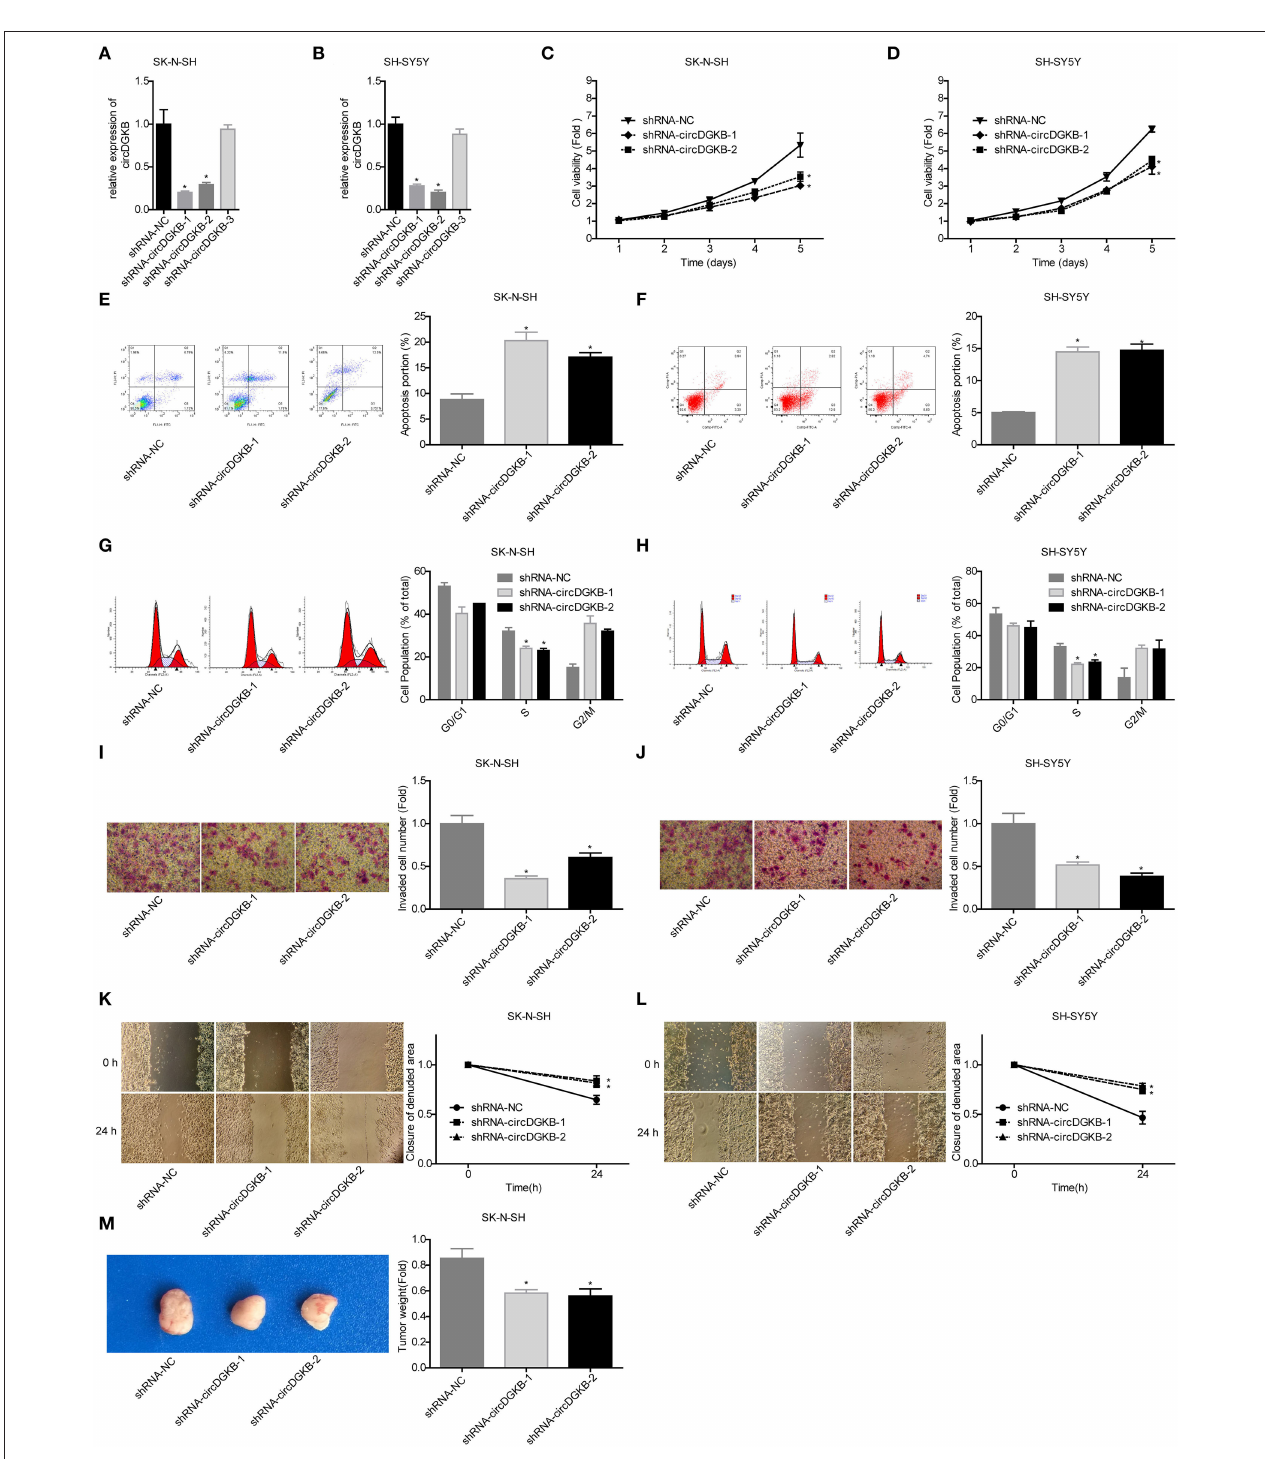
FIGURE 2 | Evaluation of the roles of circDGKB knockdown in NB cell proliferation, apoptosis and cell cycle, migration, invasion, and tumorigenesis. (A,B) QRT-PCR was taken to detect the infected efficiencies of shRNAs-circDGKB in SK-N-SH and SH-SY5Y cell lines. (C,D) CCK-8 assay was used to detect the proliferation of SK-N-SH and SH-SY5Y cells. (E,F) Flow cytometry was adopted to detected cell apoptosis. (G,H) Flow cytometry was used to determine the distribution of cell cycle. (I,J) Transwell experiment was performed to evaluate the invasion of SK-N-SH and SH-SY5Y cells. (K,L) Wound healing assay was performed to detect the migration of SK-N-SH and SH-SY5Y cells. (M) Nude mice tumorigenicity experiments was adopted to test the tumorigenesis of SK-N-SH cells in vivo (* P < 0.05 vs. shRNA-NC group).